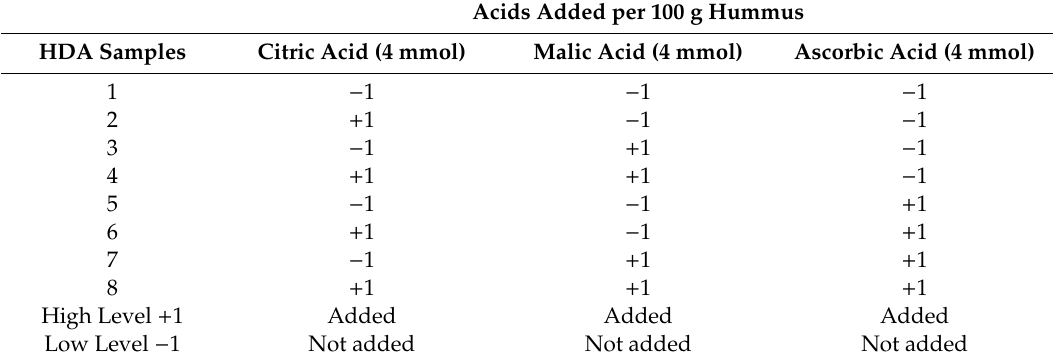
Table 2. The experimental design 2 3 (full factorial) of hummus with di ff erent acid combinations yielding eight samples of hummus with di ff erent acid content